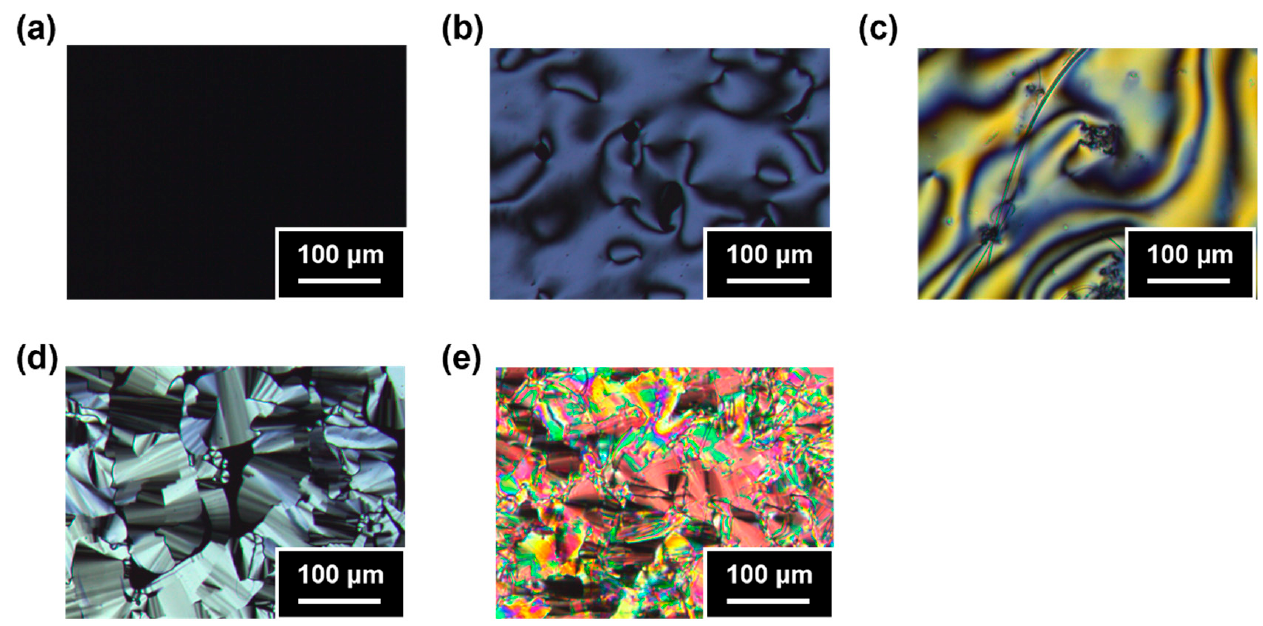
Figure 9. Polarized optical microscopic images of the pQpdS-Li /H 2 O mixtures in the 100–X:X weight ratios. ( a ) X = 95 at 25 °C, ( b ) X = 90 at 20 °C, ( c ) X = 85 at 25 °C, ( d ) X = 80 at 50 °C, and ( e ) X = 70 at 25 °C.